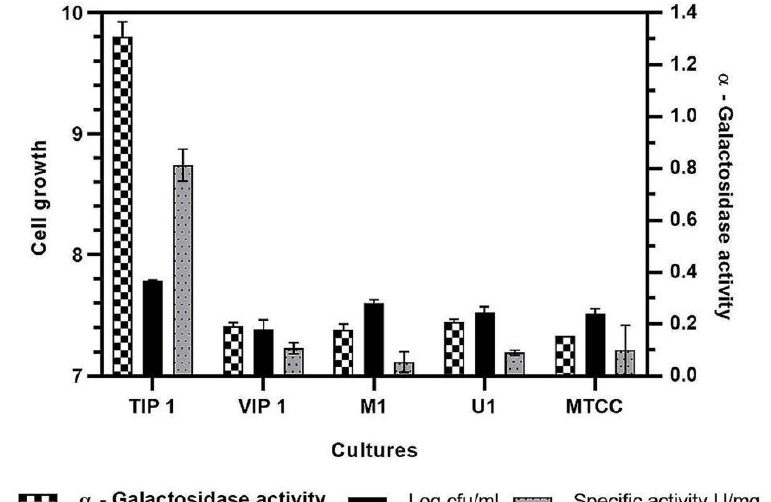
Fig. 3. Evaluation of a -galactosidase activity, cell growth and specific activity for different Lactobacillus isolates in mMRS